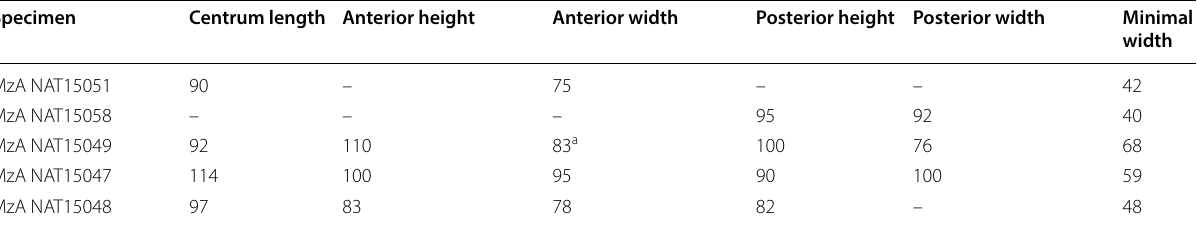
Table 3 Measurements of vertebral remains from Schleitheim Santierge held in the MzA, tentatively referred to Schleitheimia